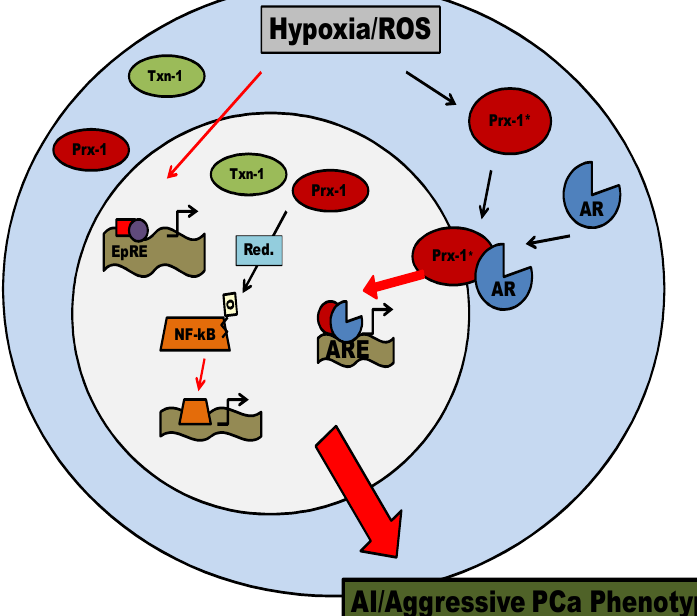
Figure 6. A Putative Model for Prx-1 and Txn-1 Mediated Signaling in PCa. In PCa cells, hormones, growth factors, inflammatory cytokines, and hypoxia can increase ROS levels, triggering Prx-1 chaperone activity and Txn-1 nuclear localization. The increased chaperone activity of Prx-1 allows enhancement of AR transactivation function in the nucleus. In addition, functional nuclear Prx-1 and Txn-1 may also activate NF- κ B transactivation function via reducing its DNA binding domain [82,83,91]. Such a model may facilitate our understanding of how tumor growth may occur under circumstances of high oxidative stress leading towards an aggressive and androgen independent (AI) phenotype in PCa